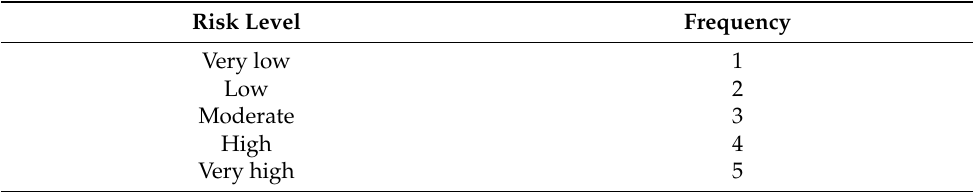
Table 5. Frequency corresponding to each risk level.